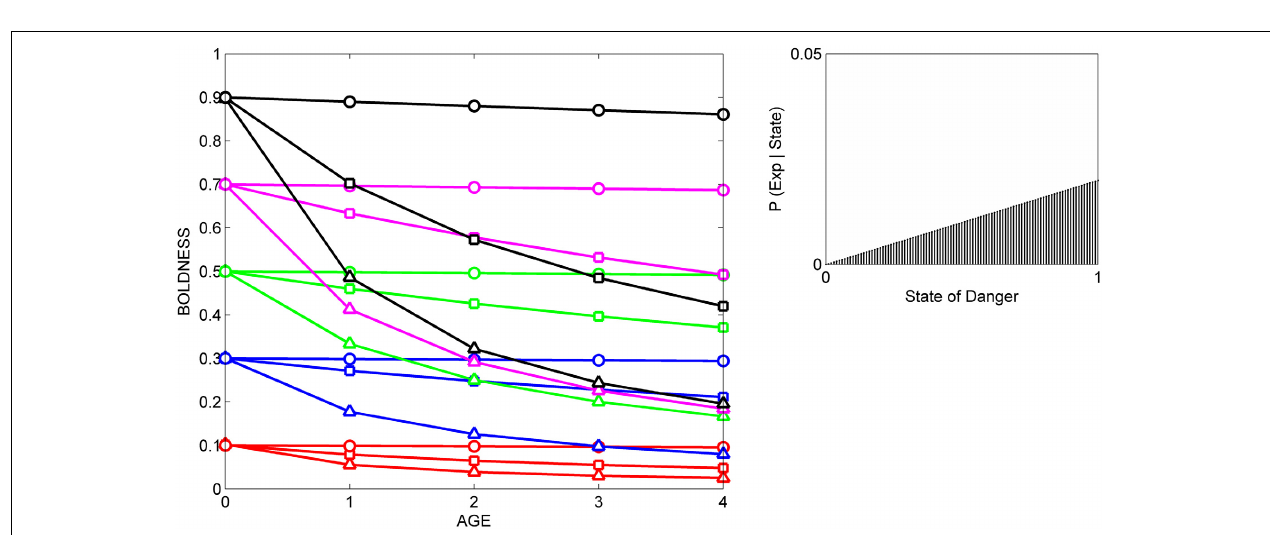
variance = 0.001, squares, variance = 0.02; triangles, variance = maximal variance for each mean). The likelihood function (right box) indicates the probability of experience given the state (P (Exp|State) for each of the 100 possible states, ranging from 0 to 1. This likelihood function is moderately reliable and left-biased (i.e., the cue is more likely to occur when danger is low than when danger is moderate to high); it was generated by a beta distribution in which α = 2 and β = 1.